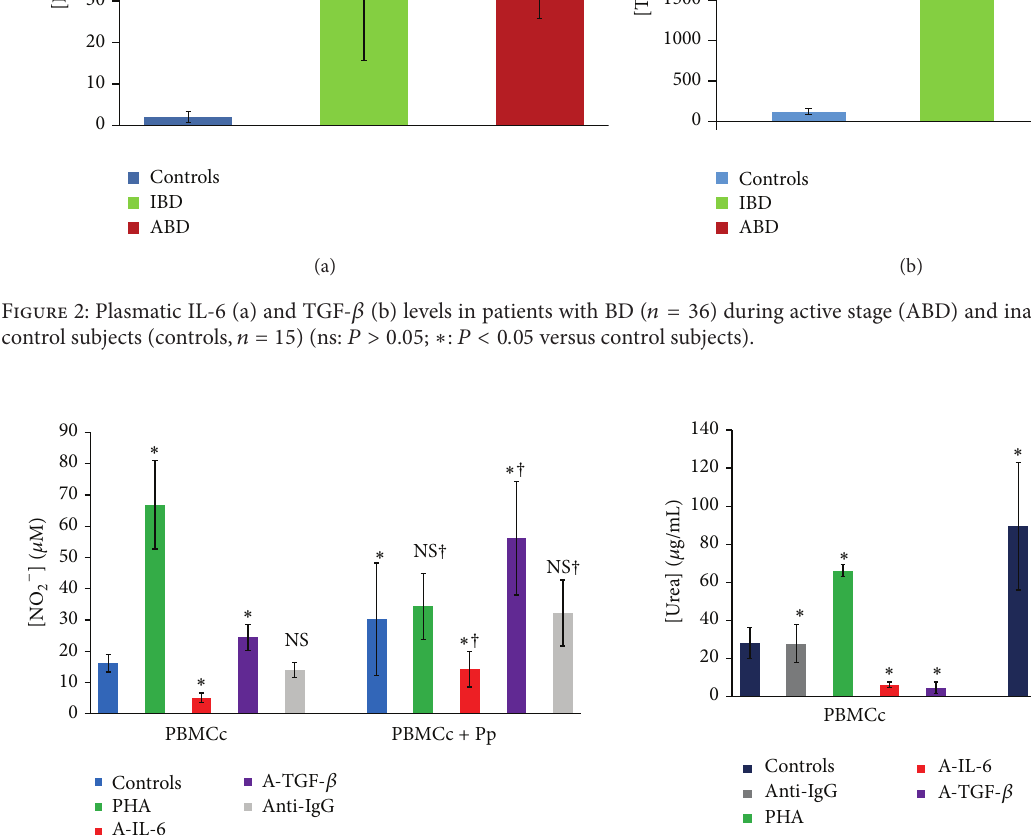
Figure 3: Patients plasma effect on nitric oxide production by cultured controls PBMC ( 𝑛 = 23 ) (ns: 𝑃 > 0.05 ; ∗ : 𝑃 < 0.05 versus controlculturewithoutinduction; † : 𝑃 < 0.05 versusculturewithout Pp) (PBMCc: controls’ PBMC, control: culture without effectors, Pp: patients’ plasma, A-IL-6: anti-IL-6, A-TGF-beta: anti-TGF- 𝛽 , and anti-IgG: isotype control IgG).